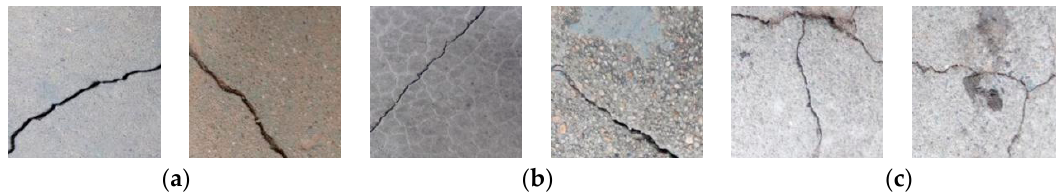
Figure 1. Examples of images contained in our dataset. ( a ) Good images, ( b ) Images with complex shading (noise), and ( c ) Images illuminated by strong light. (All displayed images have a resolution of 224 × 224).